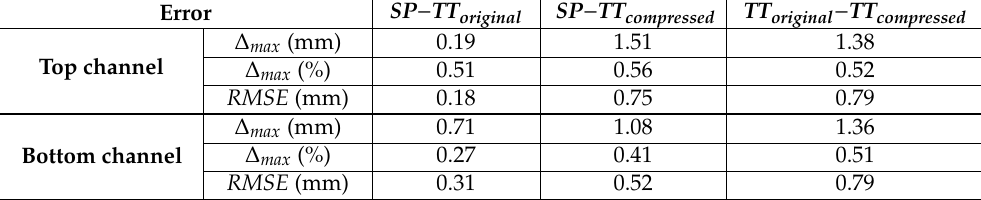
Figure 14. E-Defense full-scale RC building test and monitoring setup using two vision-based sensor systems. The optical target enclosed in white circle is used in this study to obtain seismic displacement and relative measurement accuracy using original and compressed images from both sensor systems. Table 7. Di ff erent estimates of displacement measurement error for TT using original and compressed images with respect to string potentiometer. Error SP − TT original SP − TT